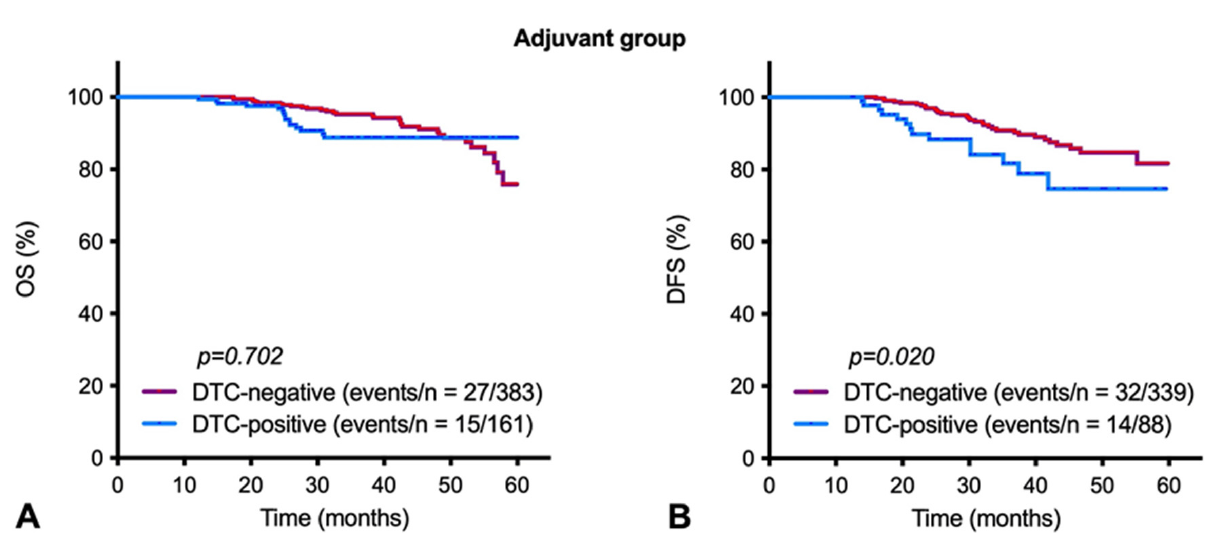
Figure A1. Univariate survival analysis by disseminated tumor cell (DTC) status before the start of adjuvant chemotherapy. Kaplan–Maier plots of ( A ) overall survival (OS) and ( B ) disease-free survival (DFS) for DTC-negative (purple line) as compared to DTC-positive (blue line) treatment-naïve patients.